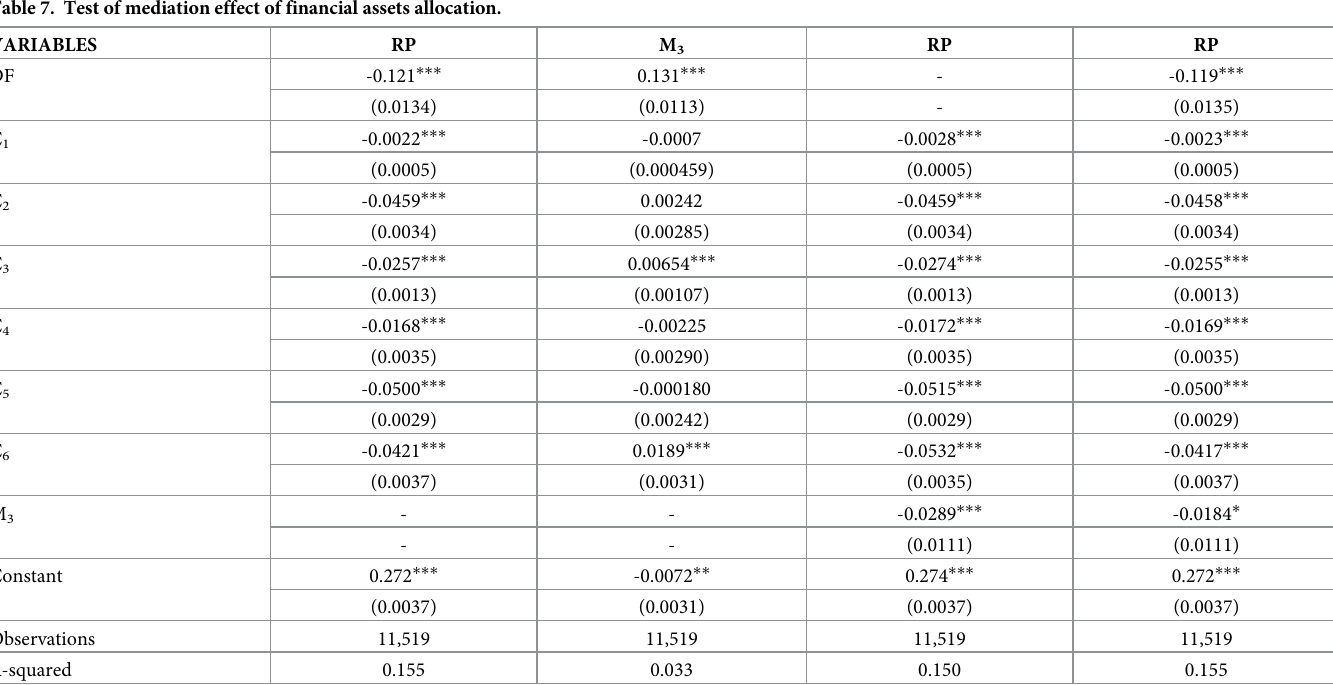
Table 7. Test of mediation effect of financial assets